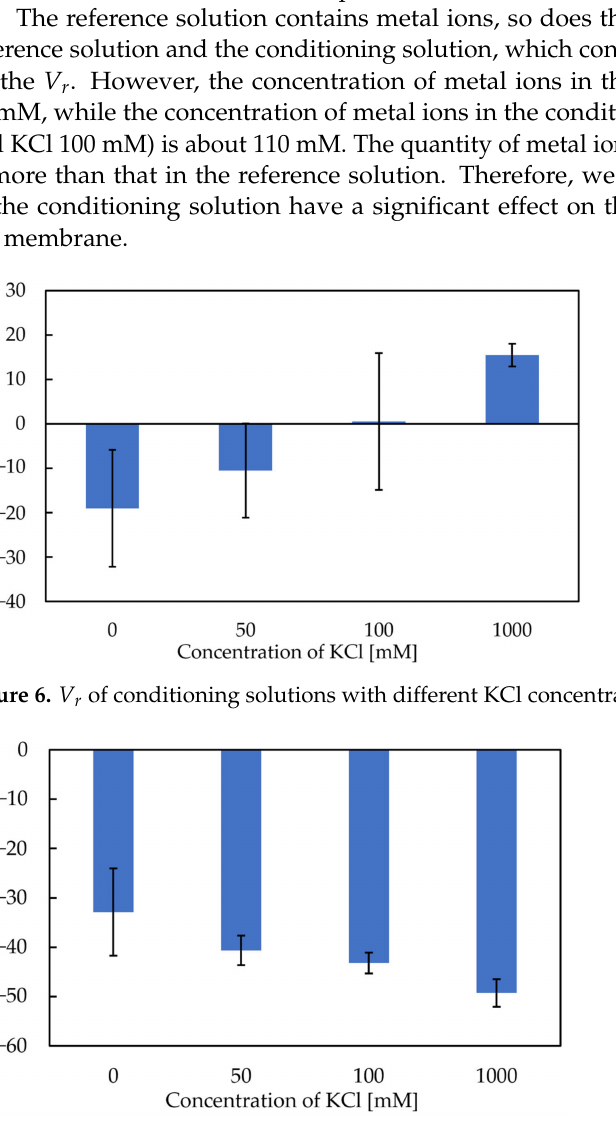
Figure 7. The sensor response to 300 mM sucrose using conditioning solutions with different concentrations of